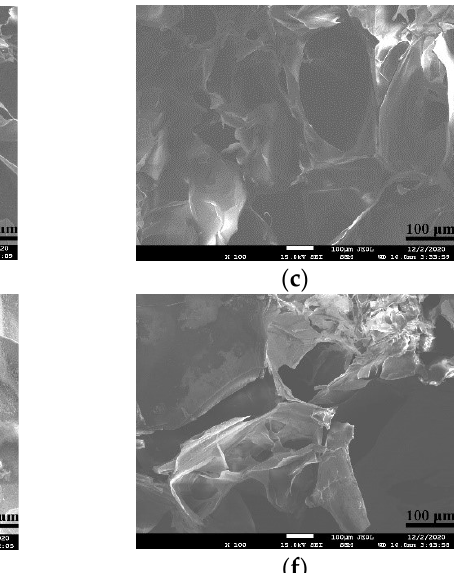
Table 2. Optimum ratio of polymer components in each group.